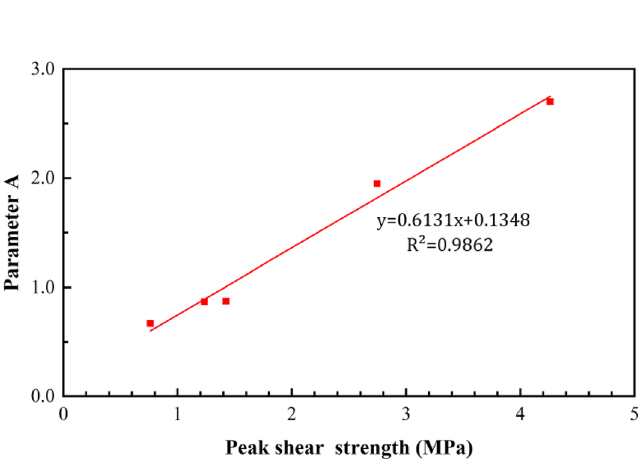
Figure 10. Comparison between the shear stress–displacement curves after the peak shear strength.